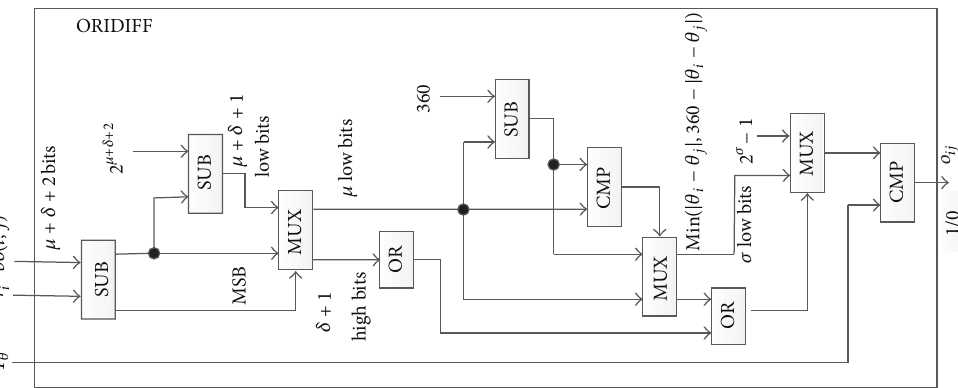
Figure 1: ORIDIFF circuit for computing (3).